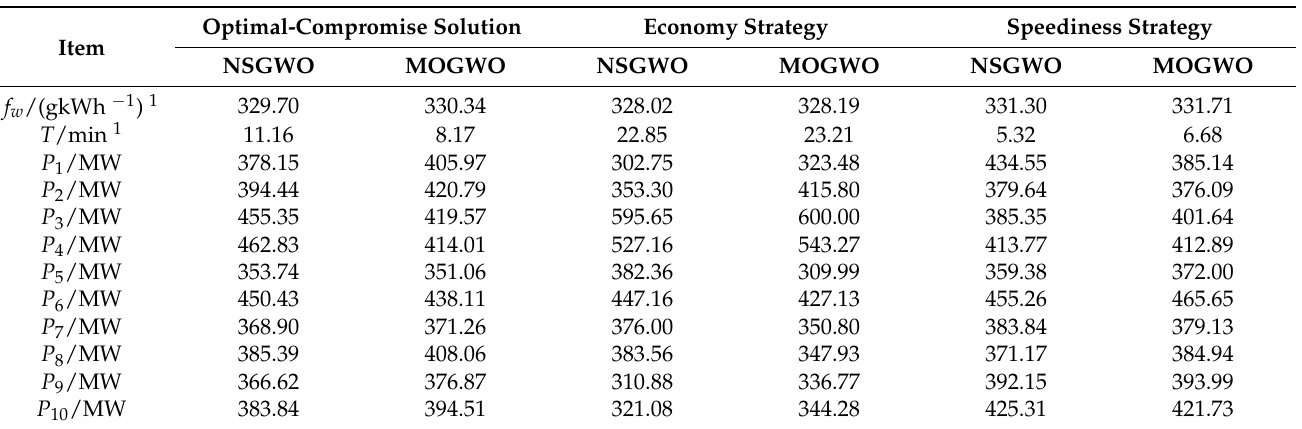
Table 11. Optimization results of load dispatch under economy and speediness strategies for a real coal-fired power plant with 10 similar-scale units.